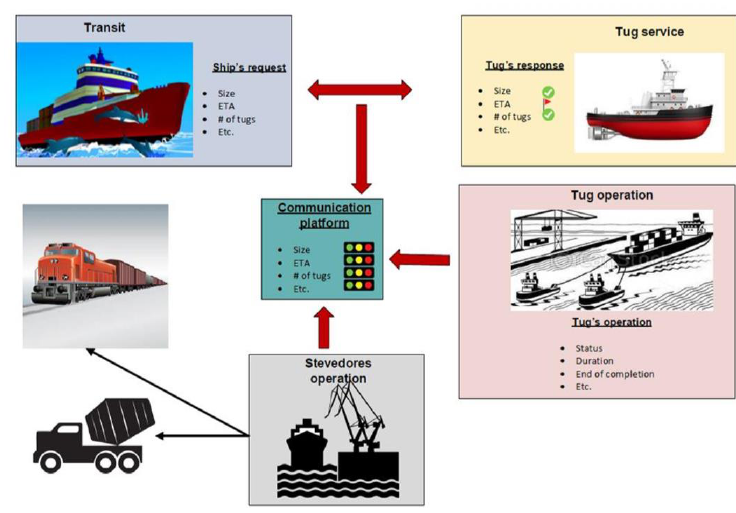
Figure 1. Example of an electronic communication platform for all actors involved in tug operations [8].